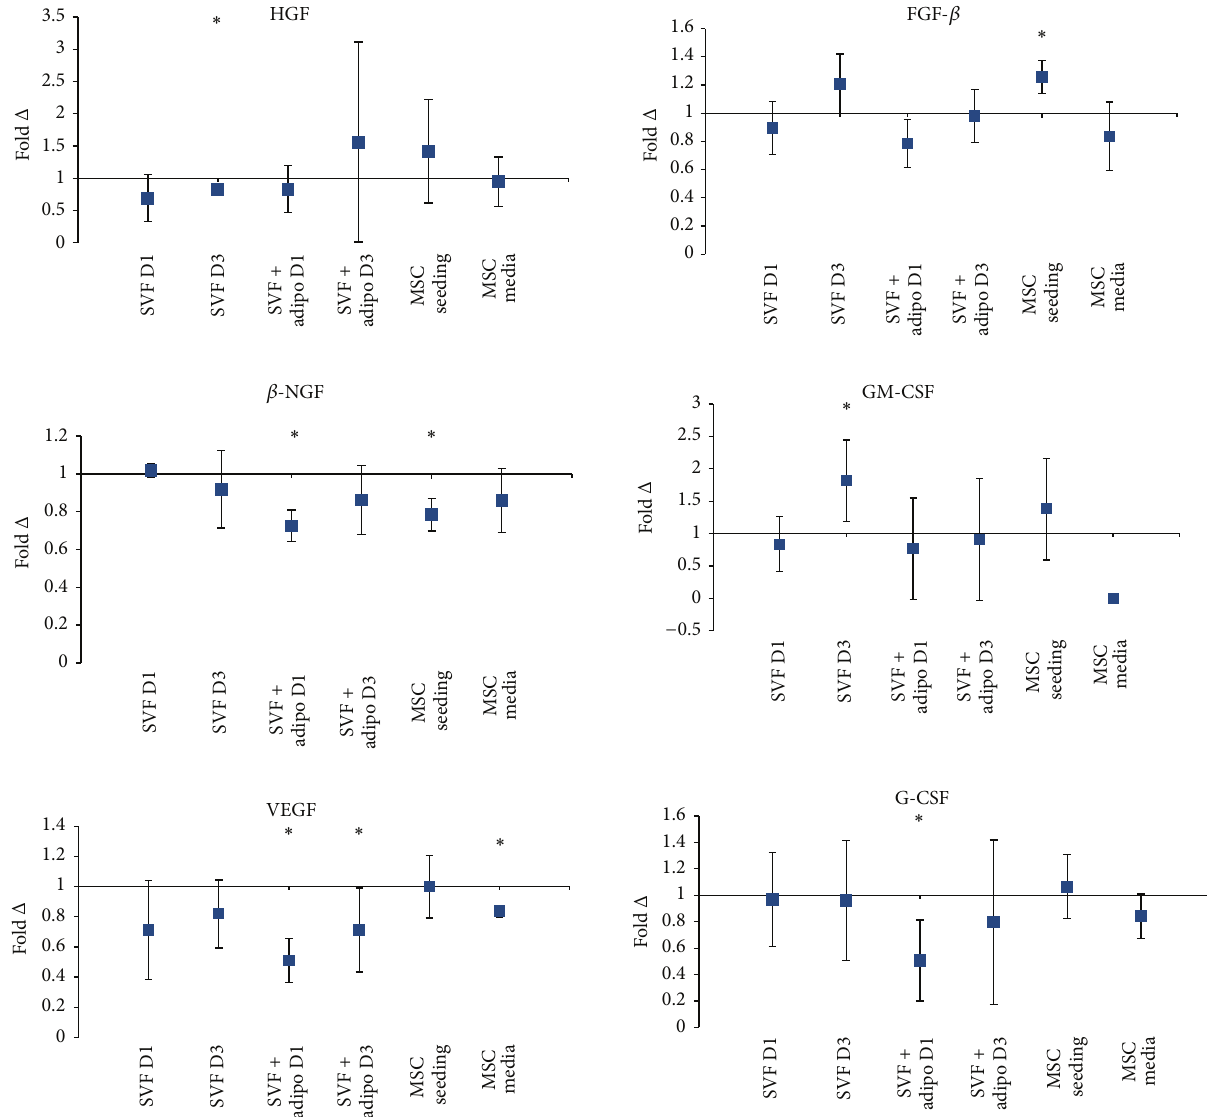
Figure 6: Fold change in concentration of growth factors detected across the experiments. Average fold change in concentration ( 𝑛 = 3 ) ± upper and lower confidence intervals at 95% ( 𝑦 -axis). Conditions ( 𝑥 -axis): stromal vascular fraction on day 1 (SVF D1), stromal vascular fraction on day 3 (SVF D3), stromal vascular fraction plus mature adipocytes on day 1 (SVF + adipo D1), stromal vascular fraction plus mature adipocytes on day 3 (SVF + adipo D3), seeding experiment with purified MSCs (MSC seeding), and media change experiment with purified MSCs (MSC media). Conditions were all cultured in either standard culture media or HA media. Cytokines with a fold change less than one indicate a decrease in concentration with HA media treatment, and a fold change greater than one indicates an increase in the cytokine with HA treatment. Hepatocyte growth factor (HGF), fibroblast growth factor-basic (FGF- 𝛽 ), nerve growth factor-beta ( 𝛽 -NGF), granulocyte macrophage colony-stimulating factor (GM-CSF), vascular endothelial growth factor (VEGF), and granulocyte colony-stimulating factor (G-CSF). GM-CSF was not detected across all biological replicates in the MSC media condition.